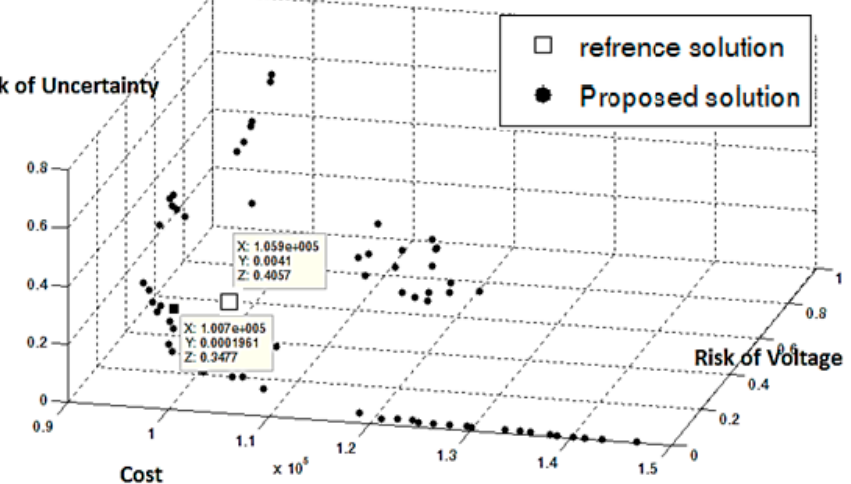
Figure 16. Comparison of reference [30] response with the Pareto Front obtained from fixed capac- itor placement. placement.